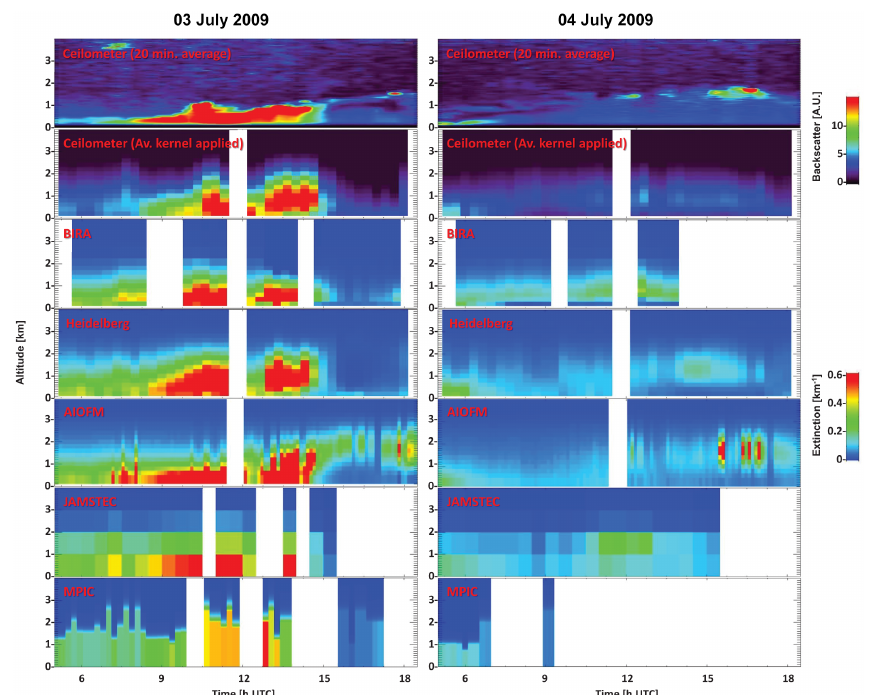
Figure 7. Same as Fig. 7 but for 3 July (left) 4 July